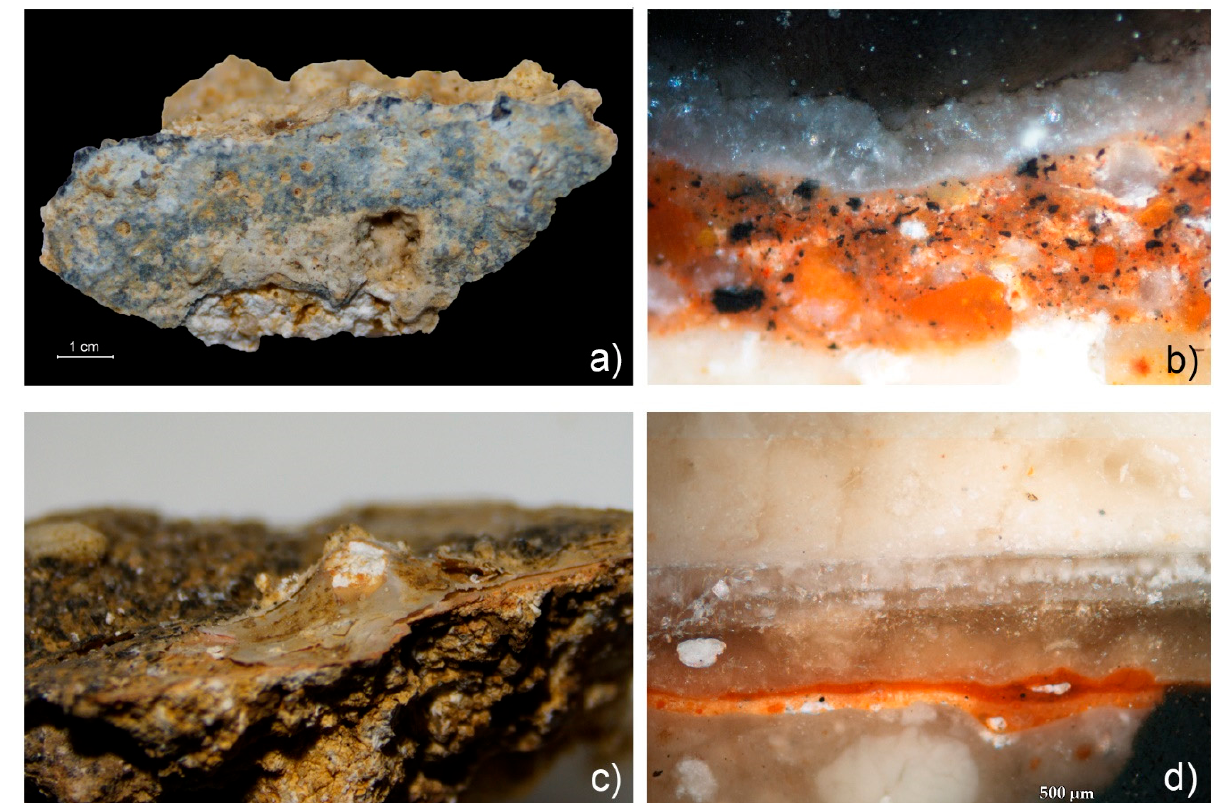
Figure 11. ( a ) Paint fragment with a thick brown–yellowish crust. ( b ) RL-OM microphotograph of a paint fragment in the cross-section showing a red pictorial layer composed by an admixture of red ochre and carbon pigments overlayered by a single calcite incrustation layer. ( c ) Paint fragment showing multilayer lamellar crusts on the surface of the pictorial layer. ( d ) RL-OM microphotograph of a paint fragment in the cross-section showing a red pictorial layer overlayered by several calcite incrustation layers.